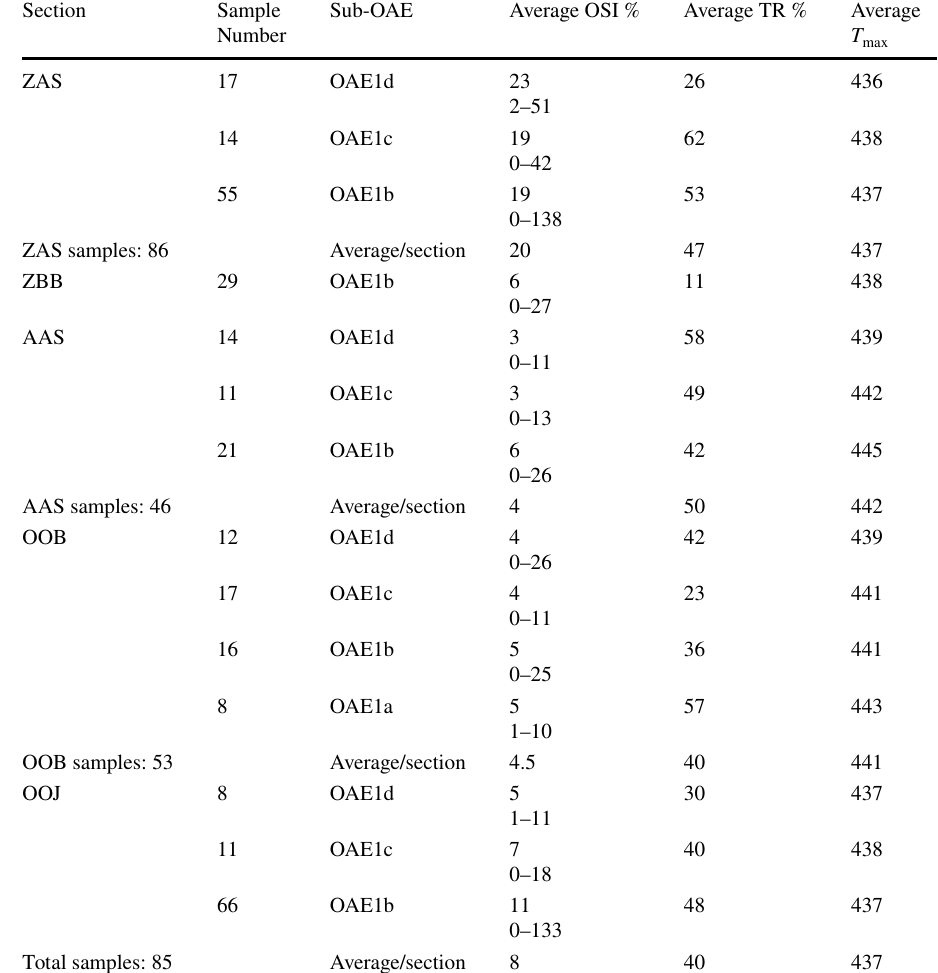
Table 3 Average oil saturation index: OSI (S1 mg × 100/g TOC), transformation ratio: TR (%) and T max of Bir M’Cherga Aptian–Albian source